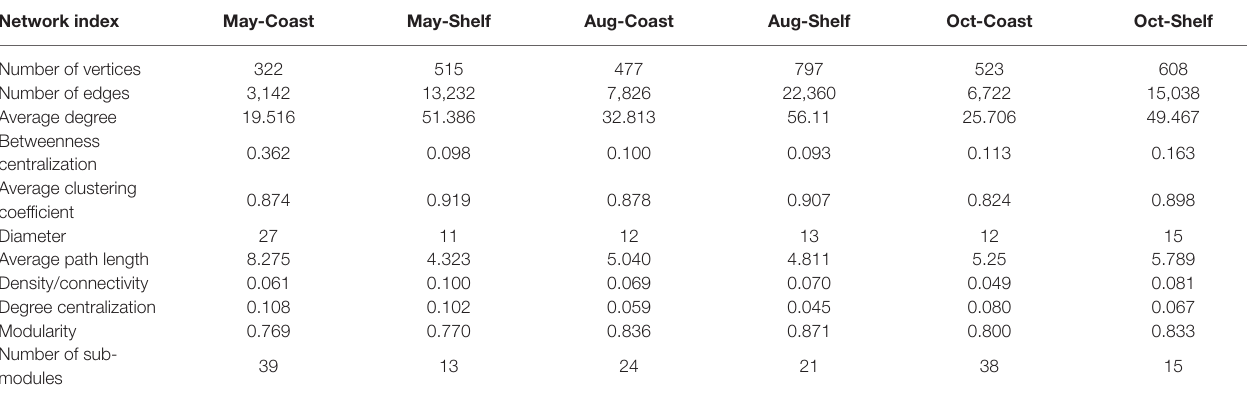
TABLE 3 | Properties of the co-occurrence networks of protist community compositions (PCCs) in the East China Sea (ECS). Network